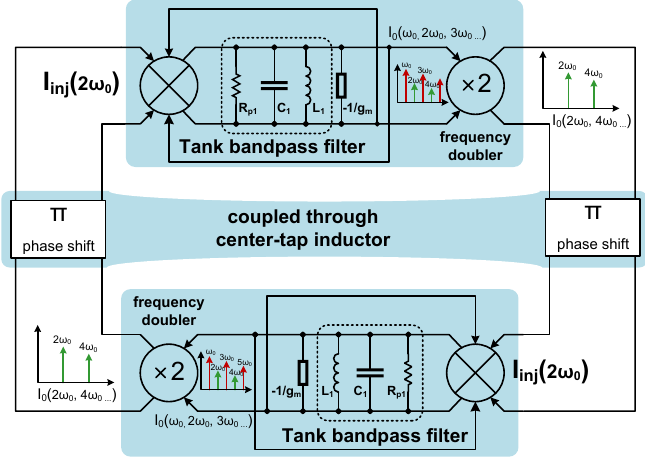
Figure 5. A simplified block diagram of the SQVCO where two oscillator cores coupled with each other through a center-tap inductor.